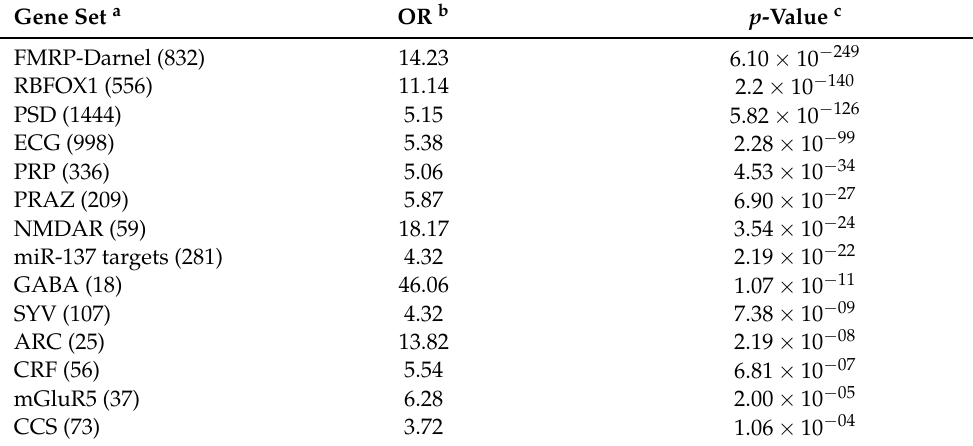
Table 1. Enrichment of top 1000 predicted genes in gene sets implicated in SCZ. Gene Set a OR b p -Value c FMRP-Darnel (832)